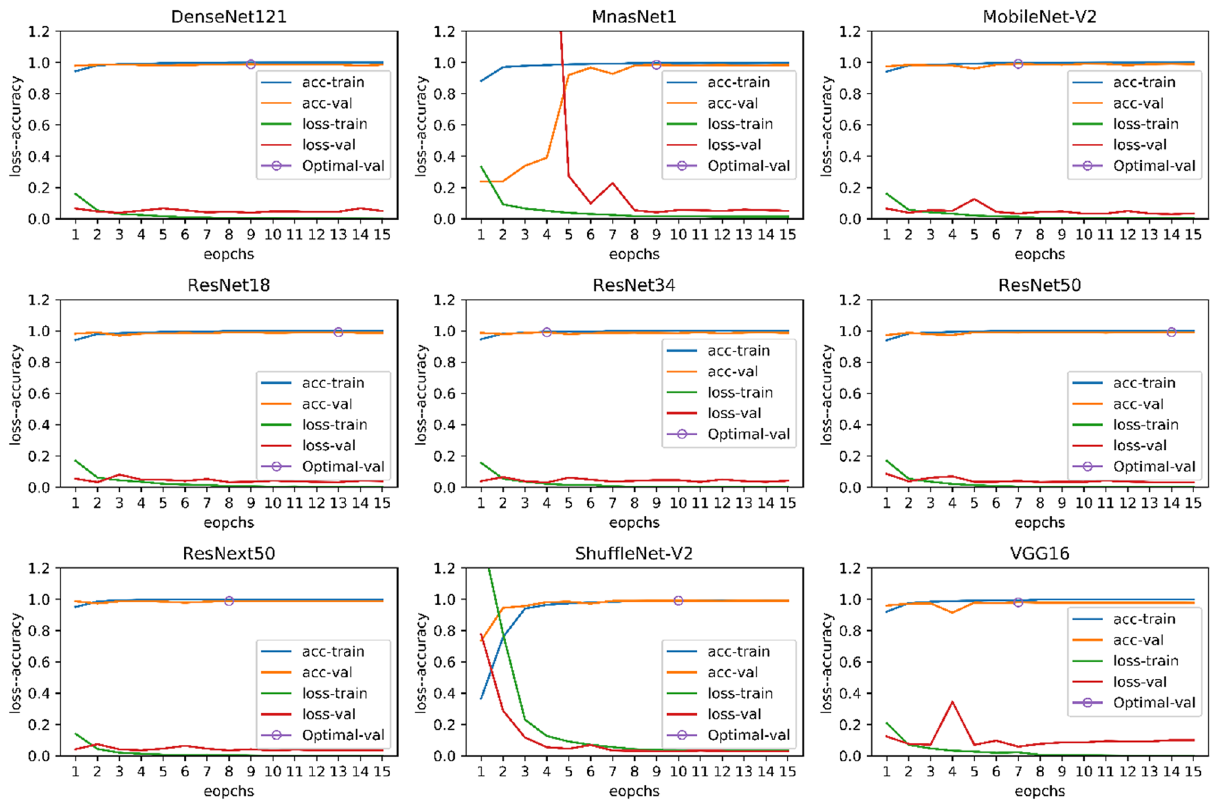
Figure 11. The plots of the accuracy and loss of training data and validation data related to nine pre-trained